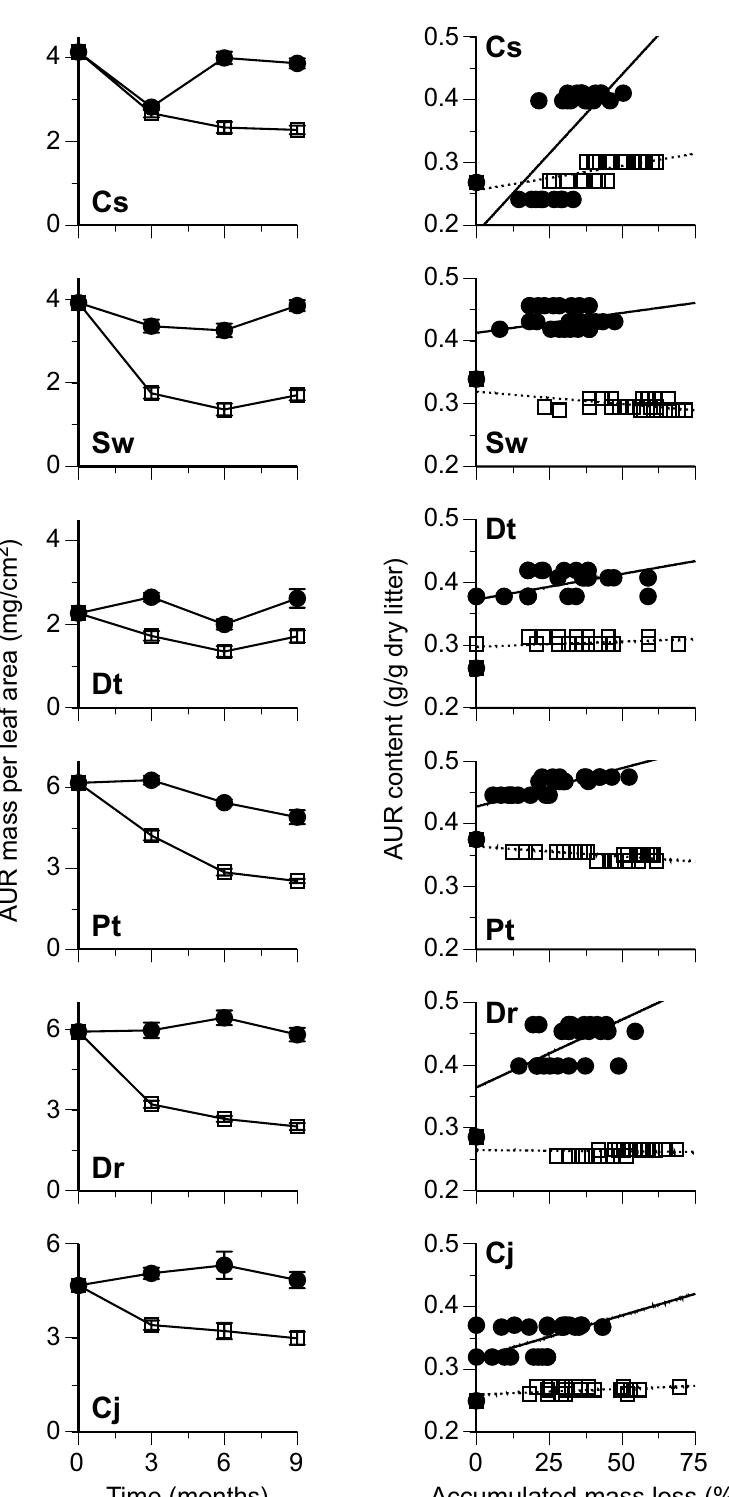
Figure 3. Changes in acid-unhyrolyzable residue (AUR) mass per leaf area (left) and relationship between accumulated mass loss and AUR content (right) in bleached (open square, dotted line) and nonbleached portions (filled circle, black line) during decomposition. Codes on the panels indicate the first letter of genus and species names of tree species. Bars indicate standard